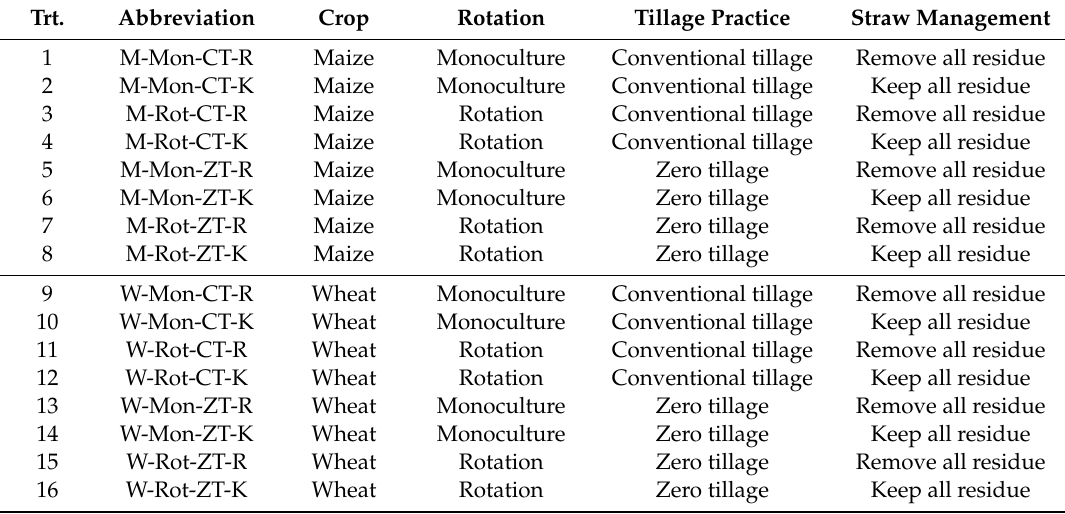
Table 1. The 16 treatments (Trt.) of the long-term trial in Texcoco, Mexico, used in this study. A total of 32 treatments were used throughout the trial.